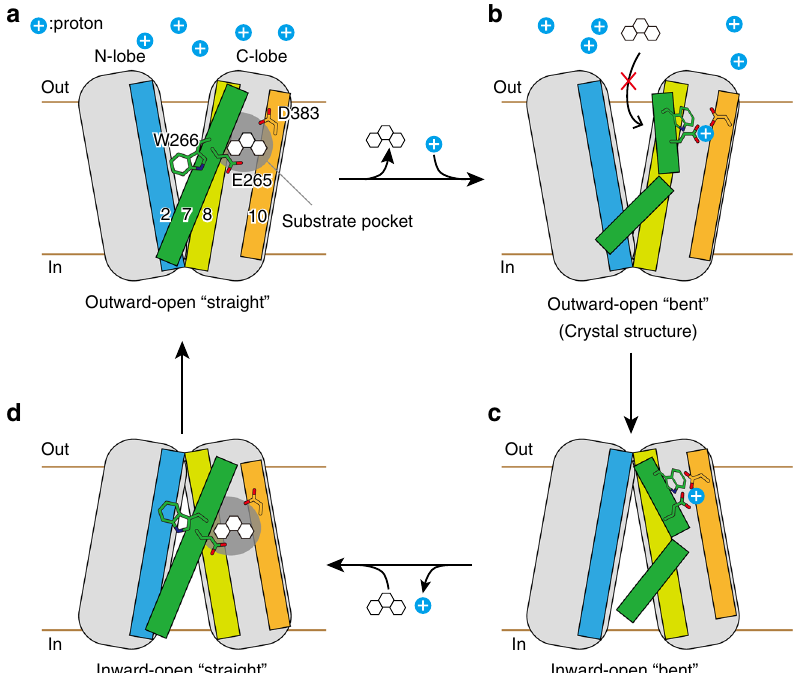
Fig. 8 Proposed transport mechanism of the eMATE transporters. Schematic diagram illustrates the possible transport cycle of the eukaryotic MATE transporters. The key residues involved in the substrate recognition and the conformational change are